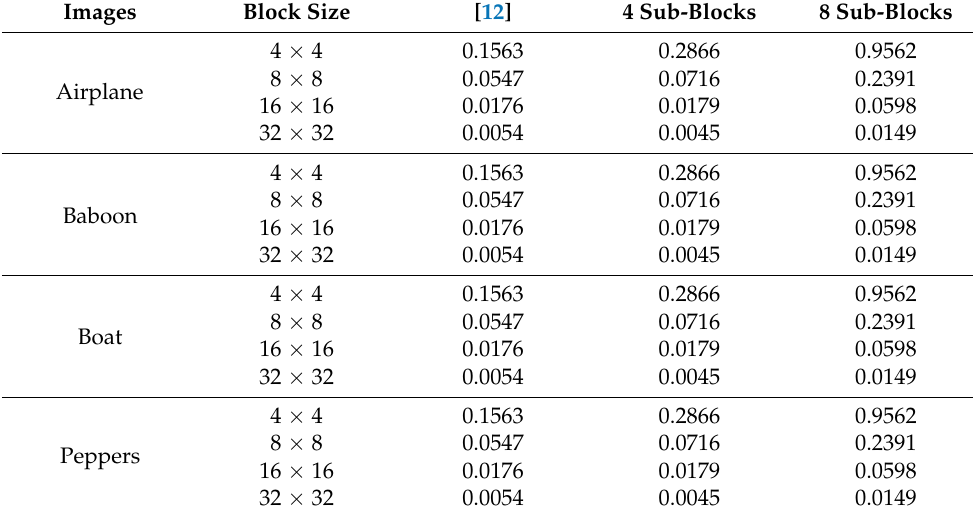
Table 10. Comparison of Embedding Rate γ